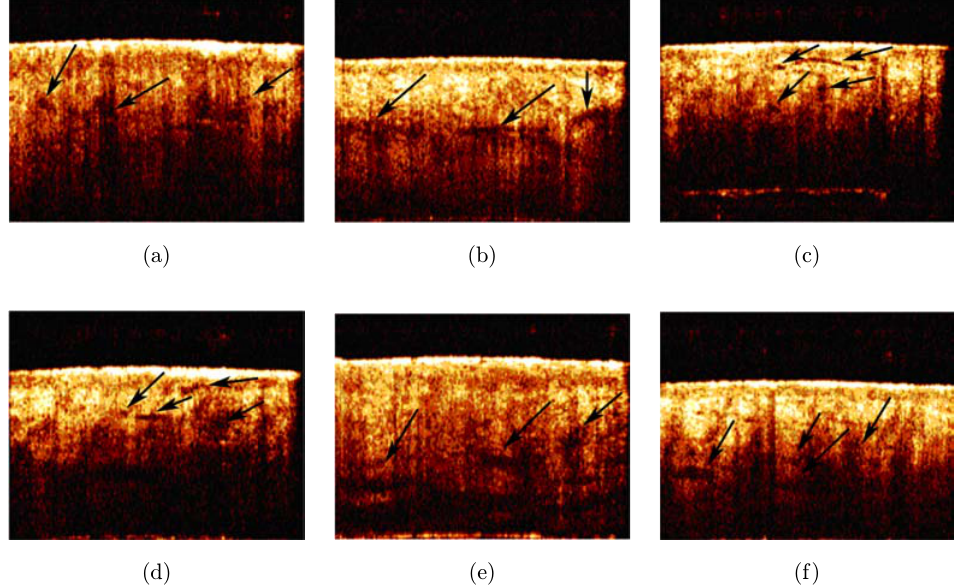
Fig. 3. OCT image of neonatal skin of di®erent localizations, the arrows show vessels in the 3rd and 4th layers (a –